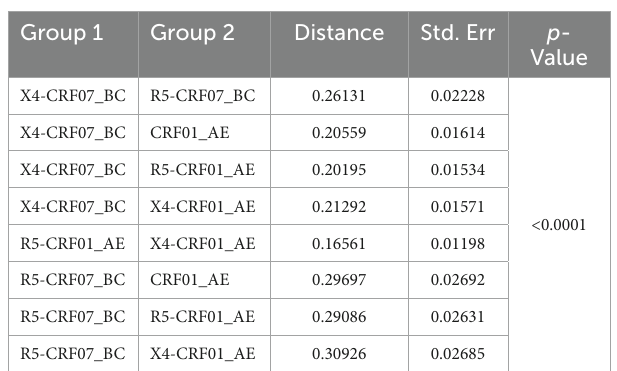
TABLE 5 Estimates of env-c2v3 evolutionary distance between the